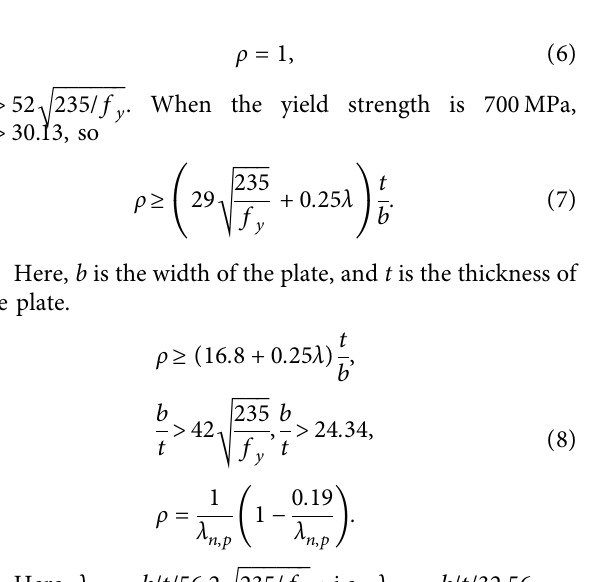
Figure 10: Comparison between the load-displacement curves obtained by experimental test and finite element simulation. (a) Load-axial displacement curves of specimens 1, 4, and 5. (b) Load-axial displacement curves of specimens 6, 8, and 10. (c) Load-lateral displacement curves of specimens 1, 4, and 5. (d) Load-lateral displacement curves of specimens 8, 9, and